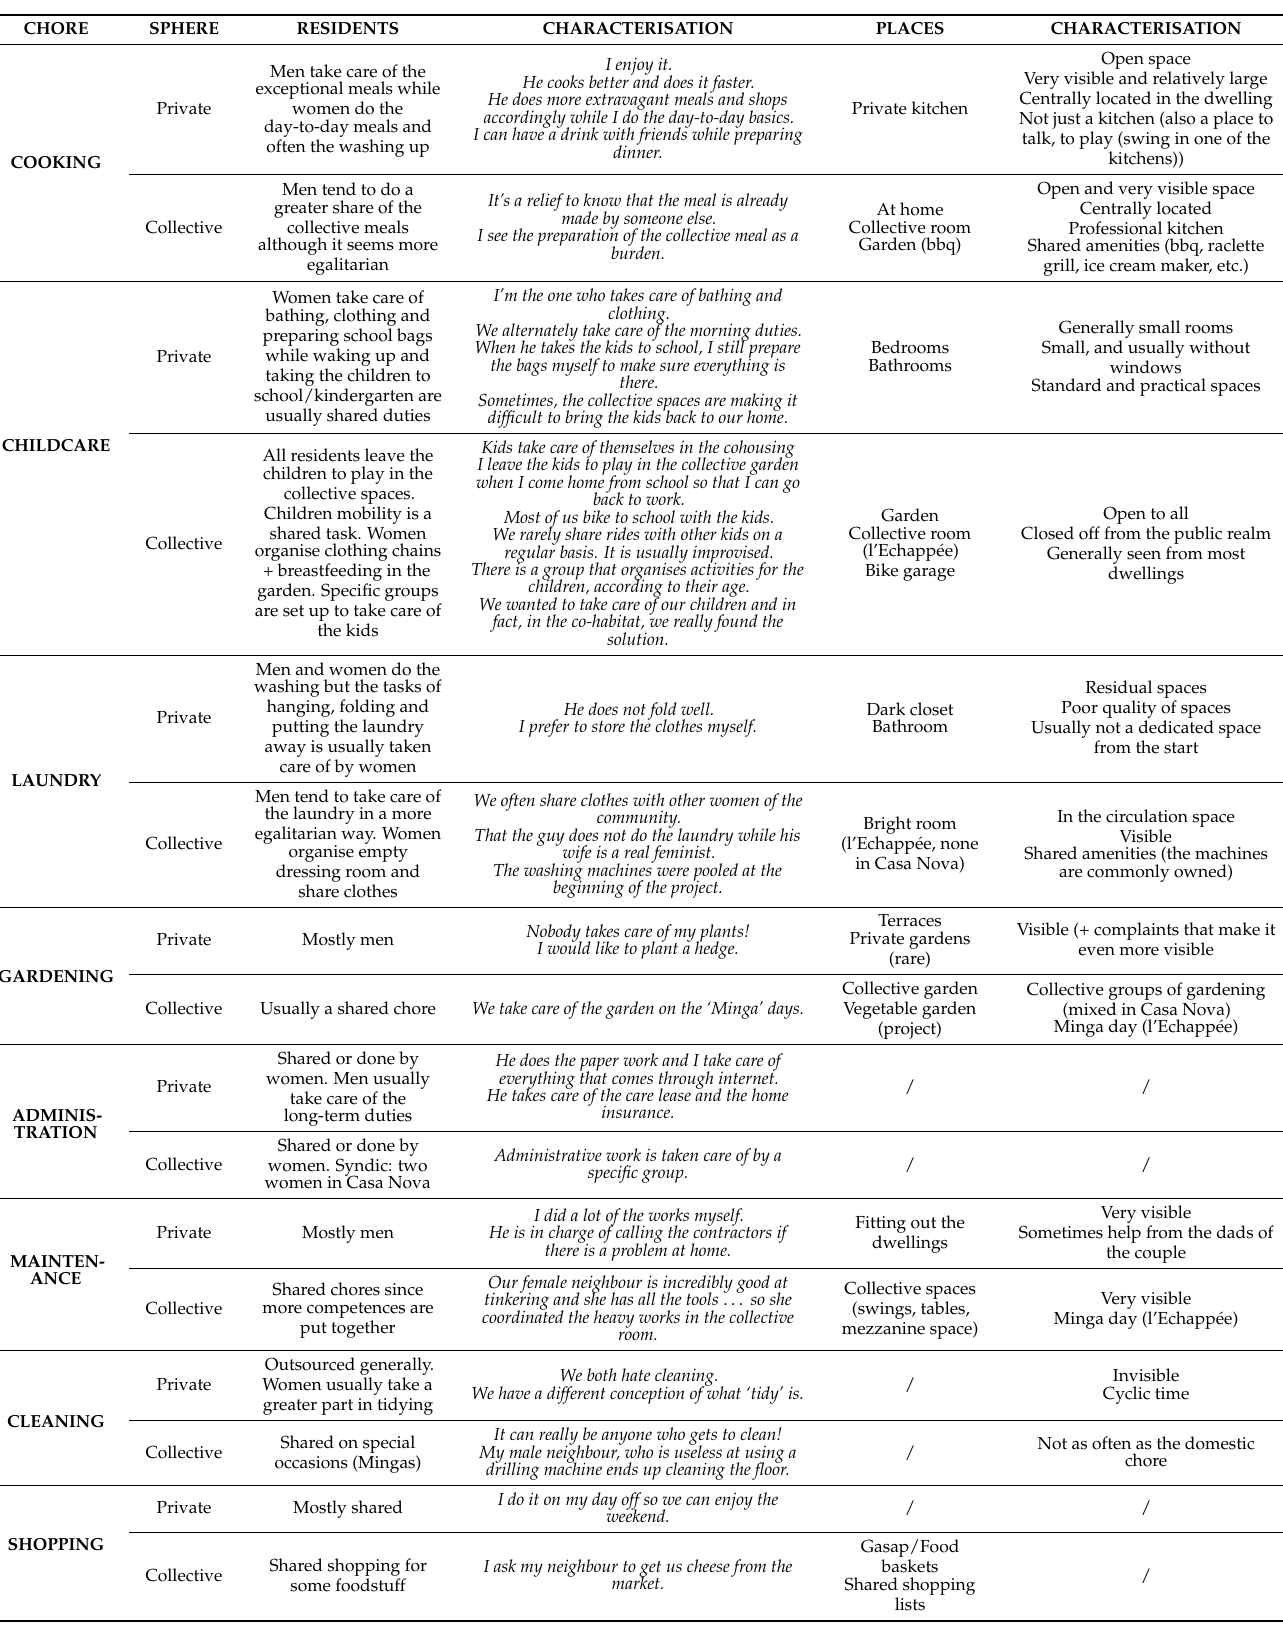
Table 1. Household chore distribution between collective and individual spaces (elaborated by the authors, 2019).